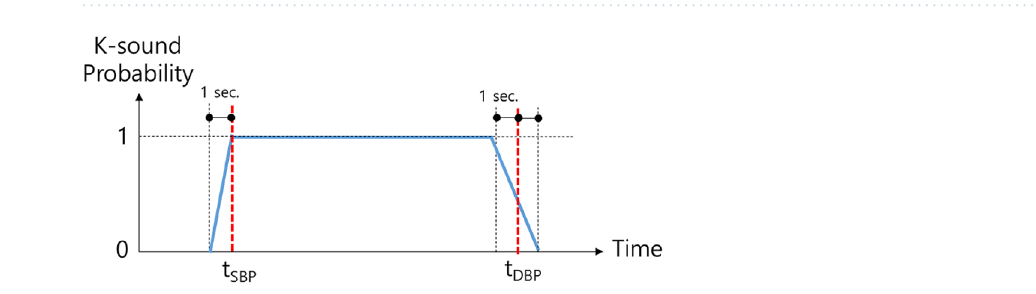
Figure 3. An example of a time signal (top left), the band pass filters (bottom left), the band-pass-filtered signals in waveforms (bottom right) and the band-pass-filtered signal stack in color (top right).